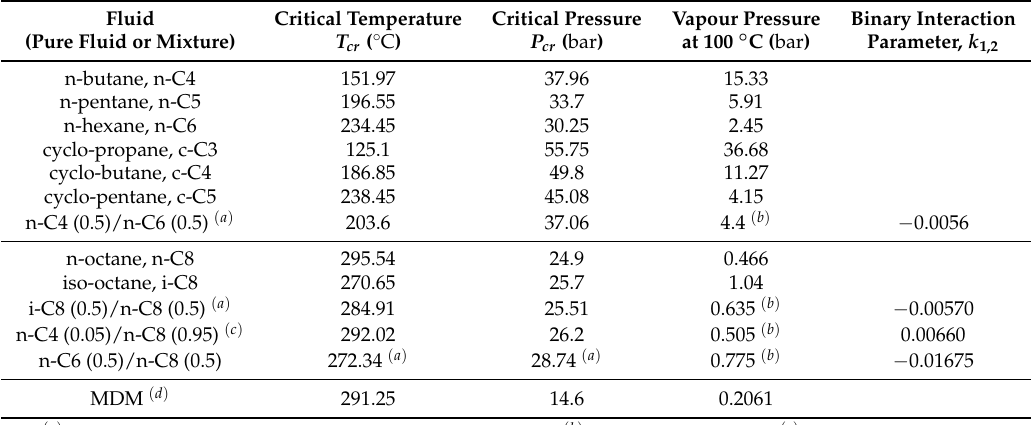
Table 3. Some parameters for the considered fluids (pure fluids and mixtures) suitable for super-critical and sub-critical thermodynamic cycles. MDM is reported as a comparison. Fluid Critical Temperature Critical Pressure Vapour Pressure Binary Interaction (Pure Fluid or